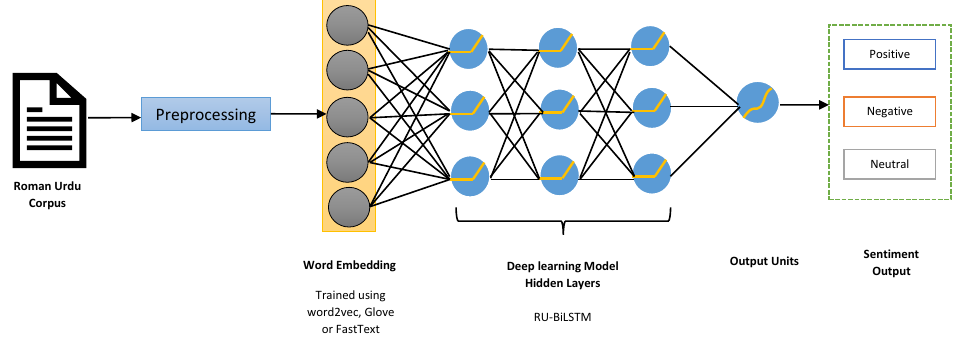
Figure 1. Proposed RU-BiLSTM deep learning